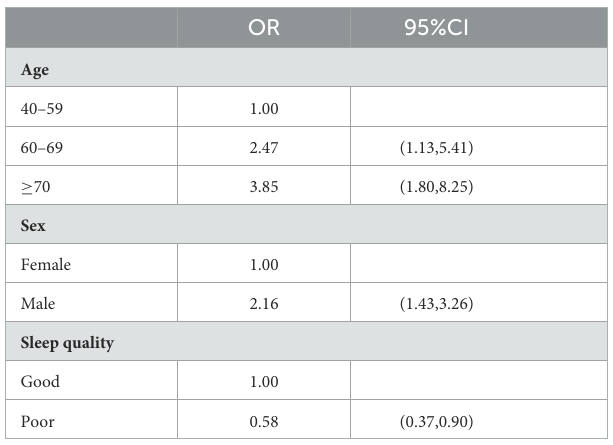
TABLE 4 Disease comorbidities of participants with/without COPD. TABLE 5 Multivariable-adjusted odds ratios for